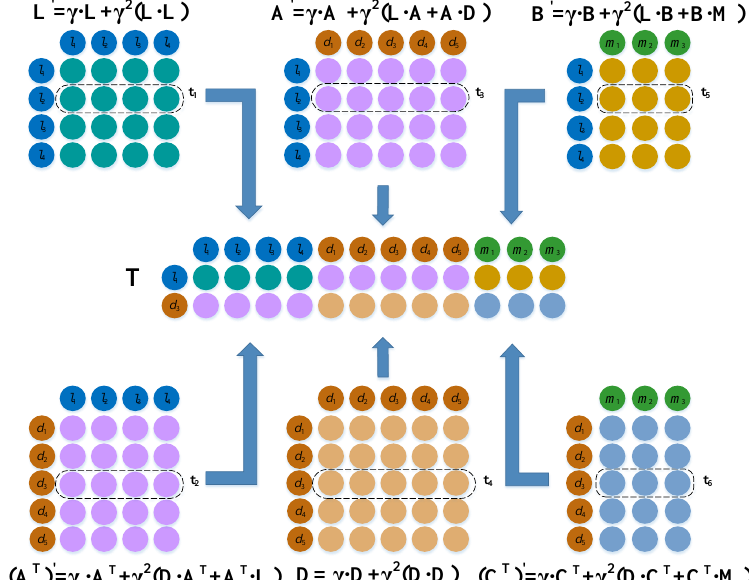
Figure 4. Construction of the topological feature matrix of lncRNA l 2 and disease d 3 .